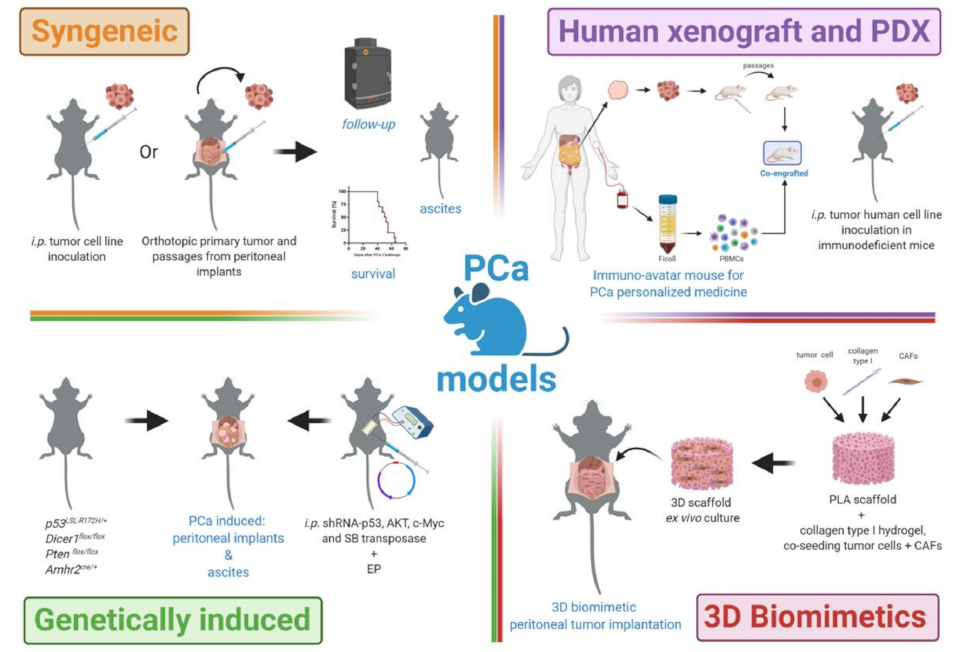
Figure 1. Peritoneal carcinomatosis mouse models. A repertoire of preclinical platforms to test new therapeutic opportunities and transfer the results to patients with peritoneal carcinomatosis. CAFs, cancer-associated fibroblasts; EP, electroporation; i.p., intraperitoneally; PBMCs, peripheral blood mononuclear cells; PCa, peritoneal carcinomatosis; PDX, patient-derived xenograft; PLA, polylactic acid; SB, sleeping beauty. Created with BioRender.com, accessed on 19 February